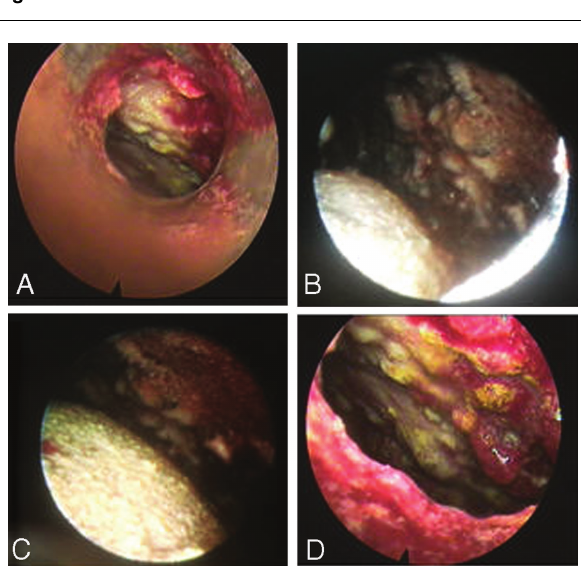
(a–d) Tetracycline powder as seen on medical thoracoscopy after insufflation into the pleural